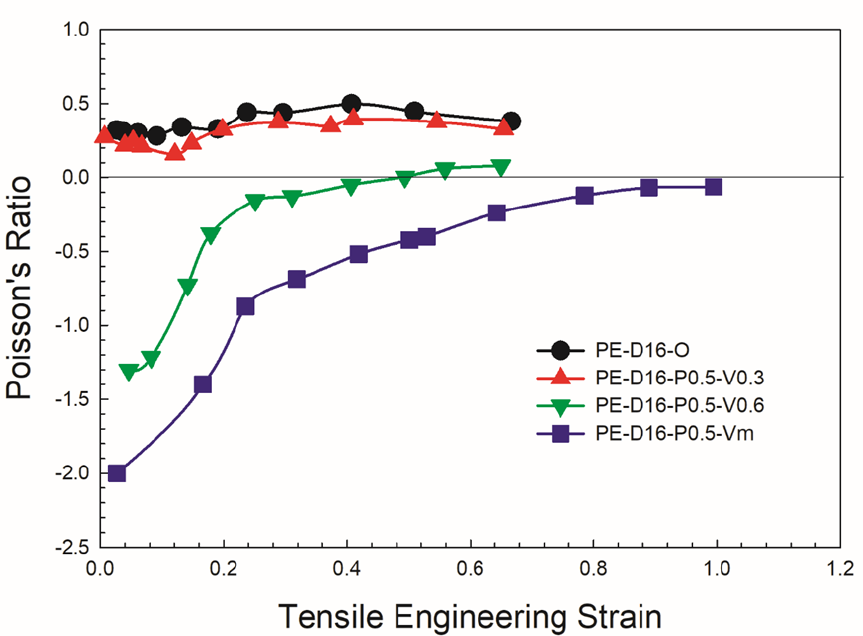
Figure 4. Poisson’s ratio as a function of tensile engineering strain for samples based on D16 (different vacuum conditions).